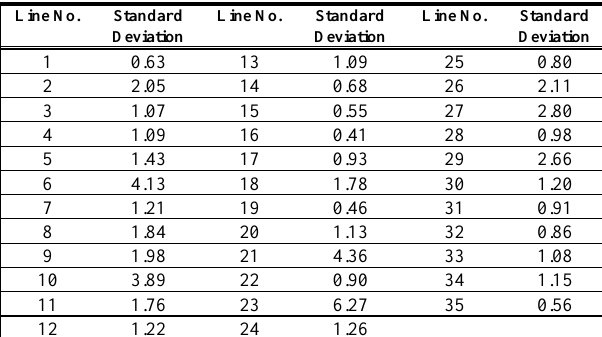
Table 4. Standard deviation values for the sides of buildings